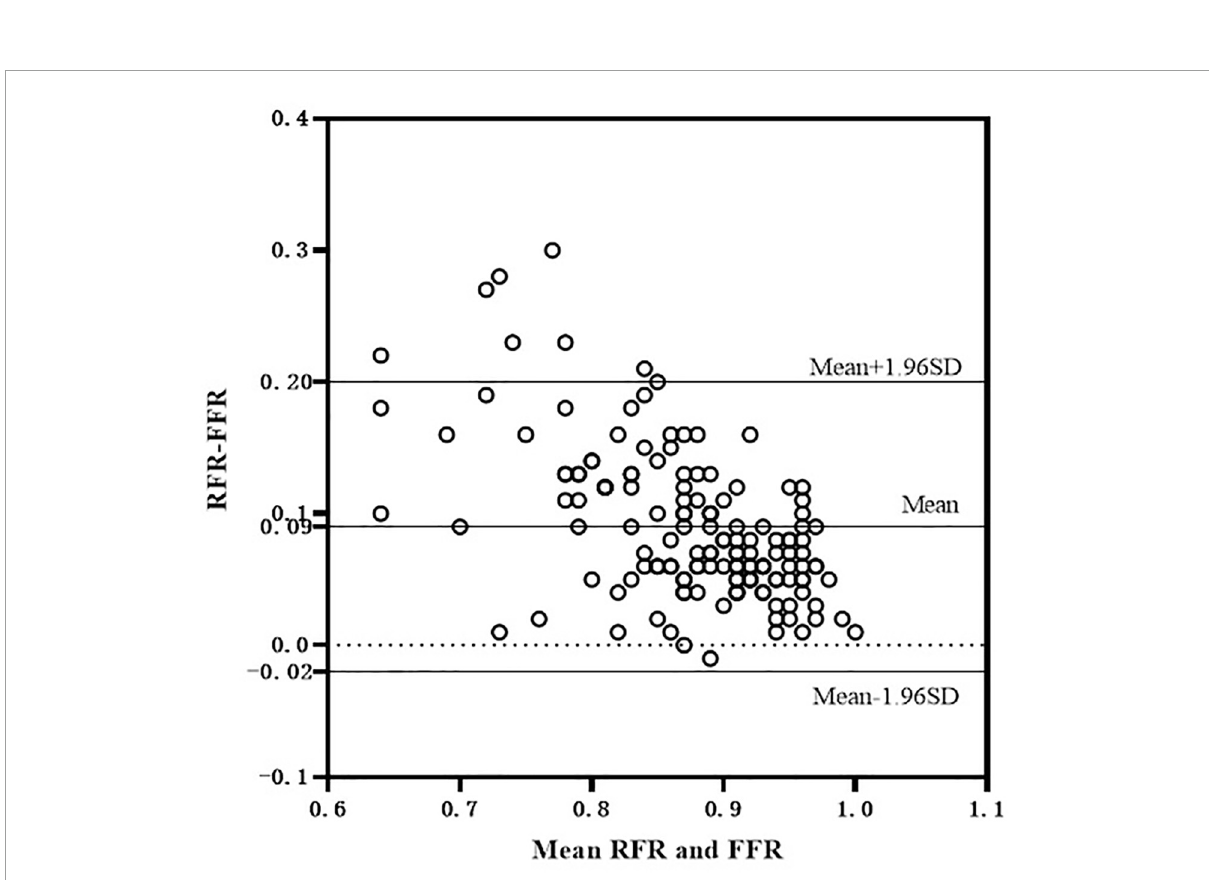
FIGURE2 Bland-Altman consistency analysis of RFR and FFR. RFR, resting full-cycle ratio; FFR, fractional flow reserve.